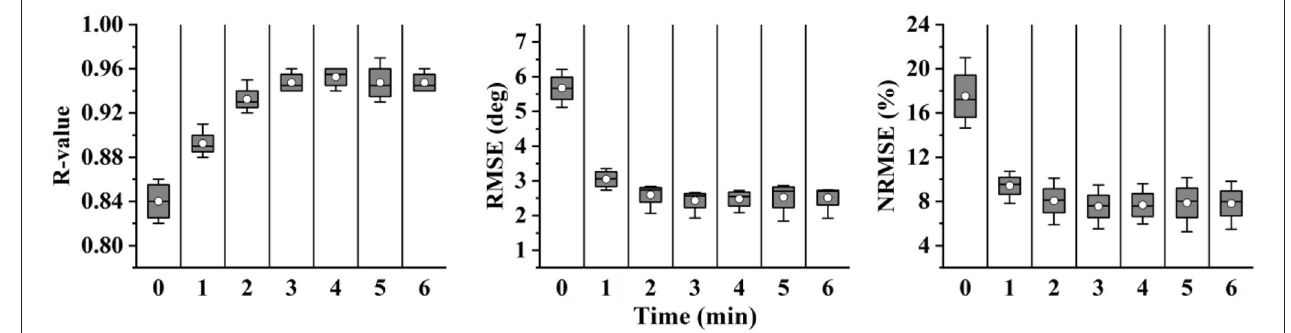
FIGURE 13 | The change of prediction performance when more data of w Exo was added to update the fine-tuning-based